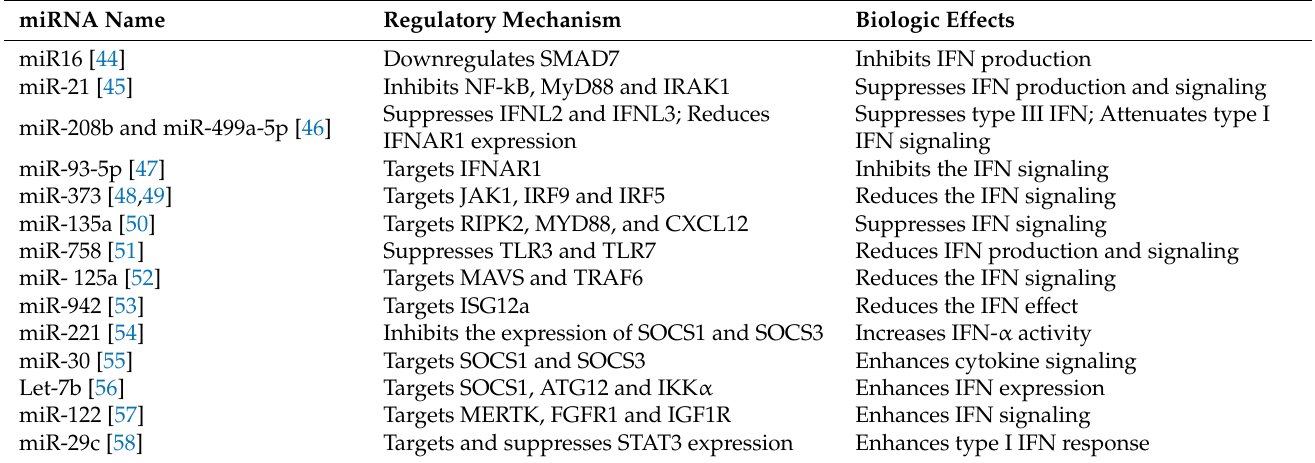
Table 2. miRNAs involved in the interferon